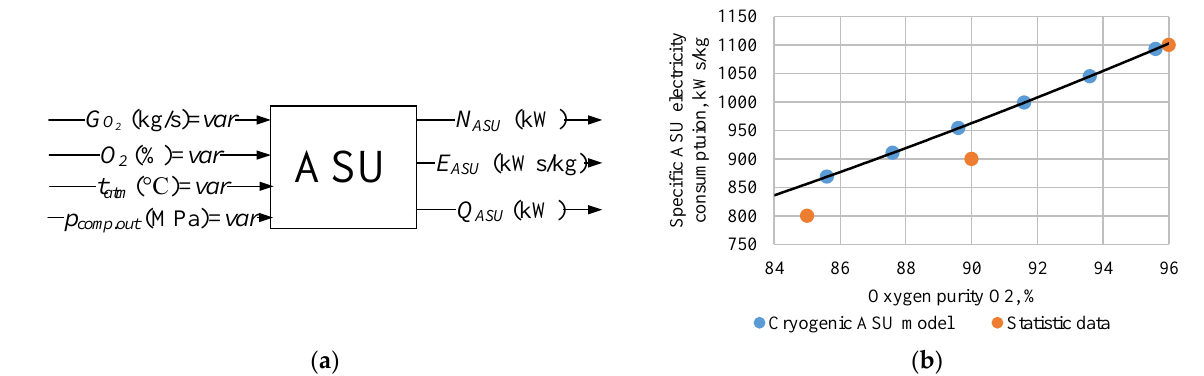
Figure 4. ASU simulation model and results: ( a ) Model; ( b ) Dependence of the specific ASU electricity consumption on oxygen purity.